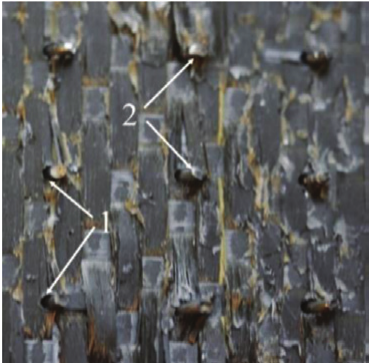
Fig. 8. Bearing (1) and shear (2) failure of the z-pins within the hybrid